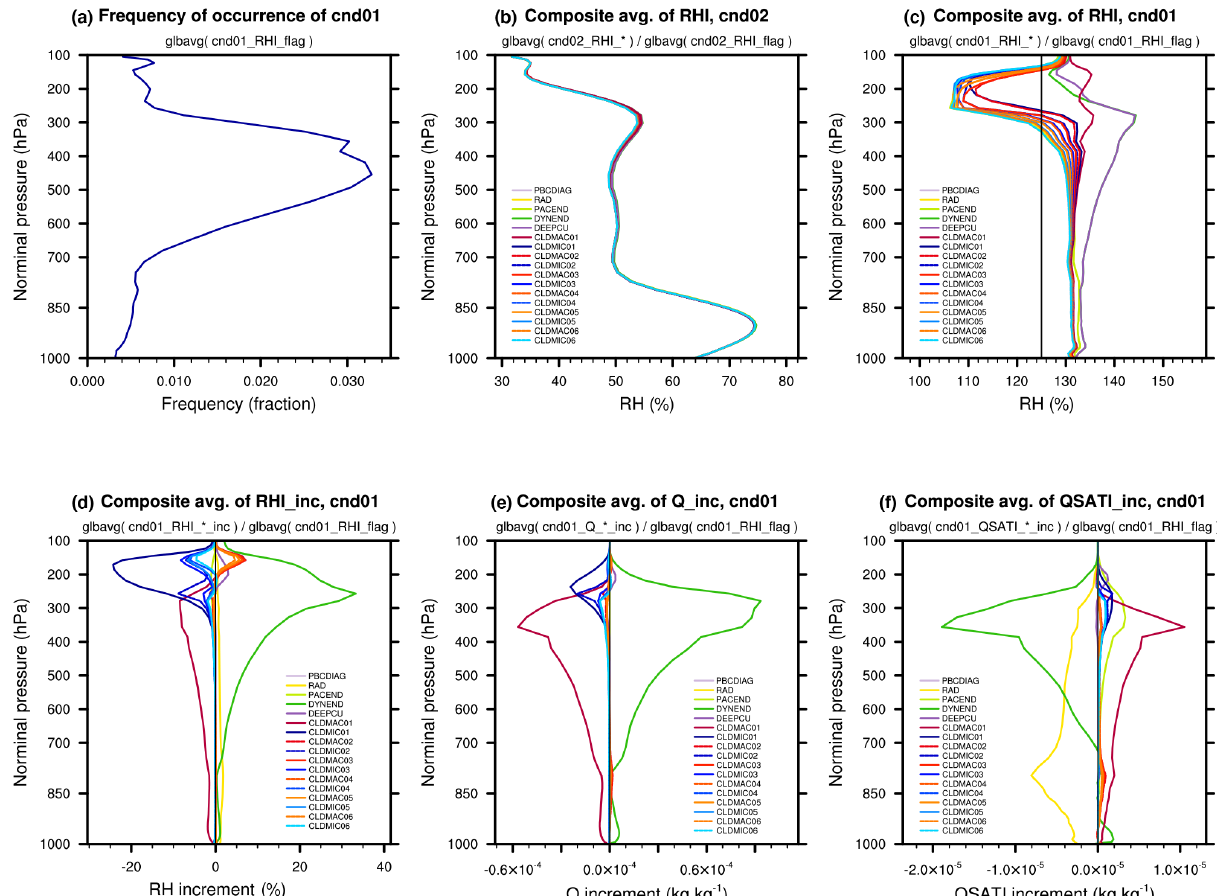
Figure 9. (a) The frequency of occurrence of RHI > 125% averaged over 1 month and the entire globe. (b) RHI at various checkpoints averaged over all time steps of the month and over the entire globe (i.e., RHI under condition 2 – unconditional sampling). (c) Space-and- time mean RHI at various checkpoints under condition 1 (i.e., RHI is higher than 125% before the first ice nucleation calculation during a time step of (cid:49)t CPLmain = 30min). Space-and-time mean increments of (d) RHI, (e) specific humidity, and (f) saturation specific humidity with respect ice averaged under condition